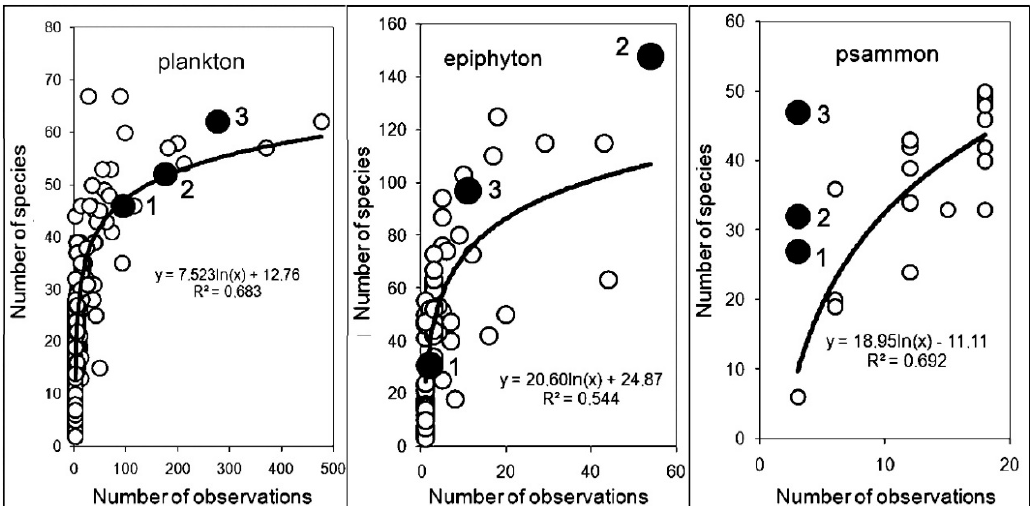
Figure 10. Numbers of rotifer species in the three habitats of Konin lakes compared to different lakes in northeastern Poland and their relation to the number of analyzed samples; p -value in all cases < 0.0001. Black circles show number of species found in the studied Konin Lakes; open circles and regression lines - data for the remaining lakes. Explanations: 1 - Lake Gos ł awskie; 2 - Lake Liche ń skie; 3 - Lake Ś lesi ń skie.